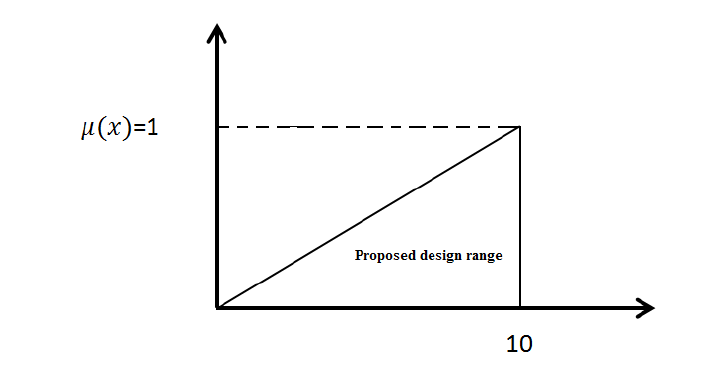
Figure 8. Proposed design range for ranking the failure modes